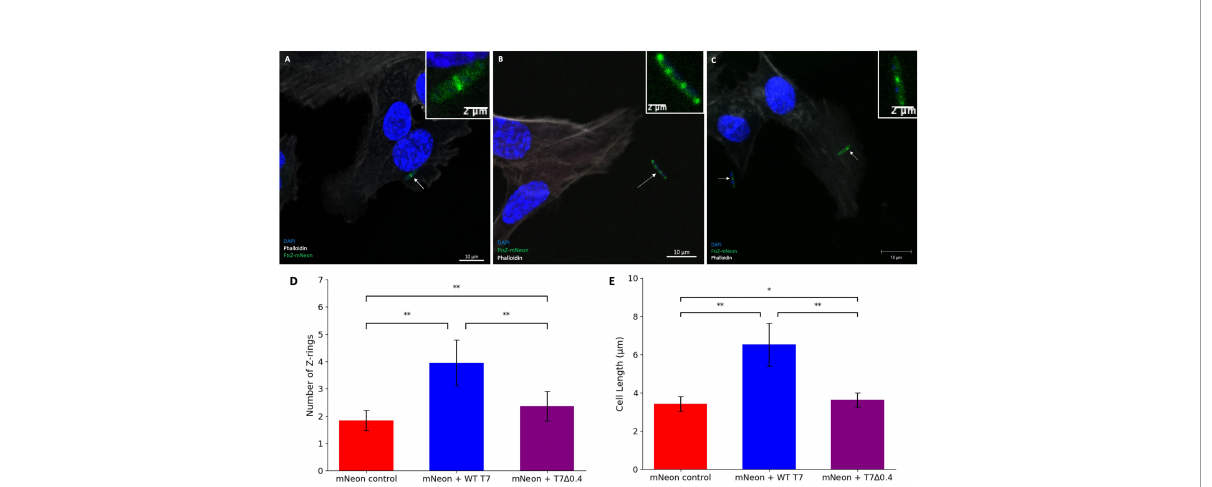
FIGURE 6 T7 D 0.4 mutant phage microscopy. (A) K12/FtsZ-mNeon control cells fi xed in human cells. (B) K12/FtsZ-mNeon cells infected with T7-mCherry phage fi xed in human cells. (C) K12/FtsZ-mNeon cells infected with T7 D 0.4 phage fi xed in human cells. For fl uorescent images, DAPI stain is shown in blue, phalloidin in grey, and FtsZ-mNeon in green. Arrows pointing to bacterial cells of interest. (D,E) Quanti fi cation of Z-ring number and cell length for 75 K12/FtsZ-mNeon bacterial cells infected with T7-mCherry or T7 D 0.4 phage during exponential growth and compared to a